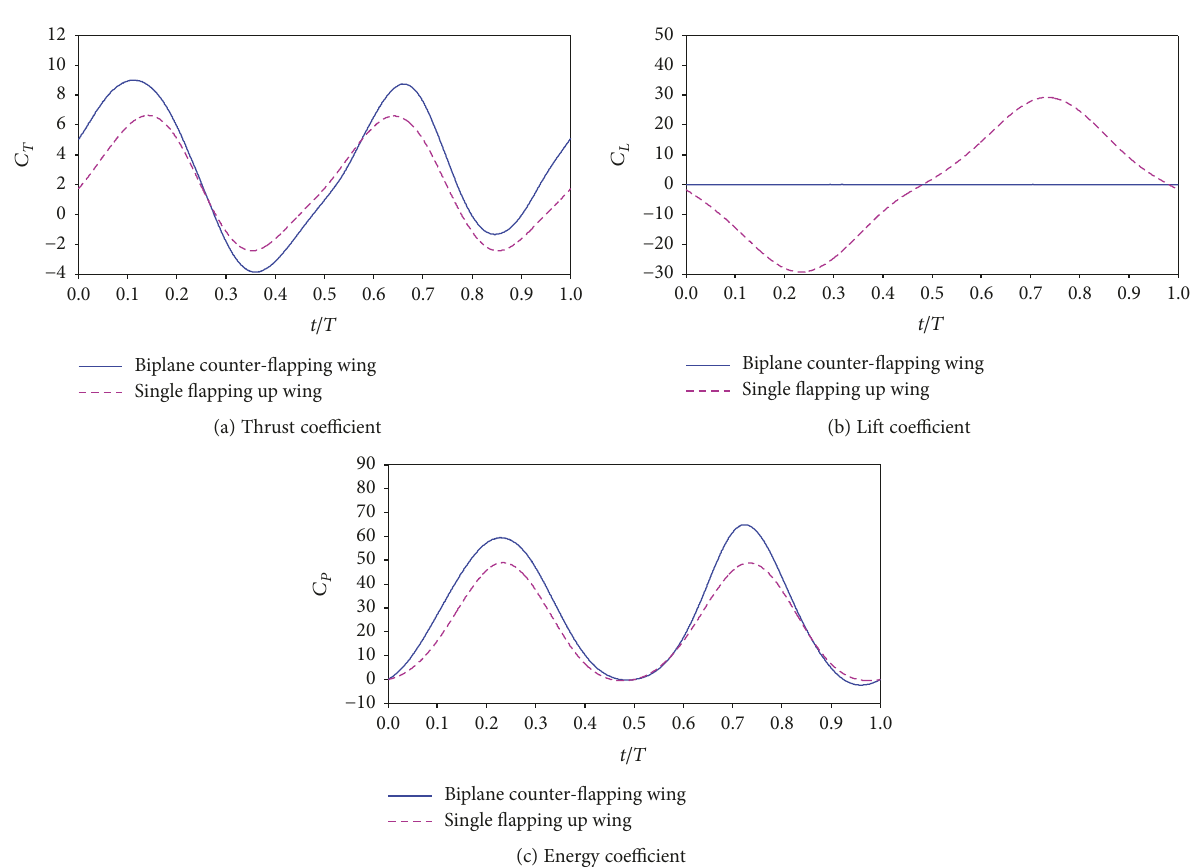
Figure 7: Time variation of the thrust coe ffi cient, lift coe ffi cient, and energy coe ffi cient of the biplane counter- fl apping wing and single fl apping up wing with ϕ = 0 °